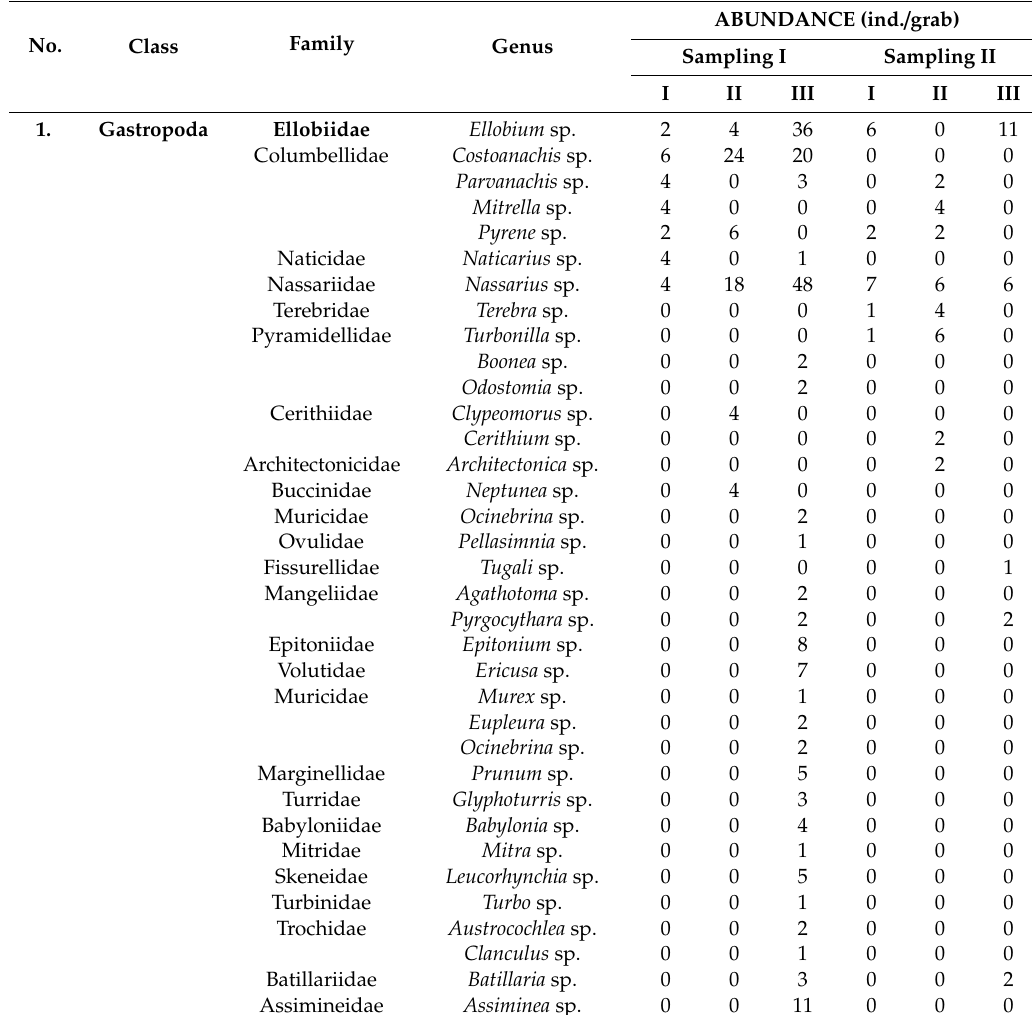
Table 1. Spatial and temporal macrobenthic assemblages at three sampling locations at Tembelas Island, Kepulauan Riau Province,